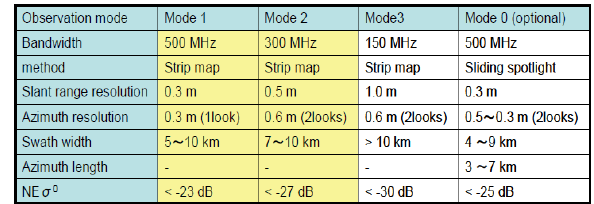
Table 1. Specification of PiSAR-L2 sensor